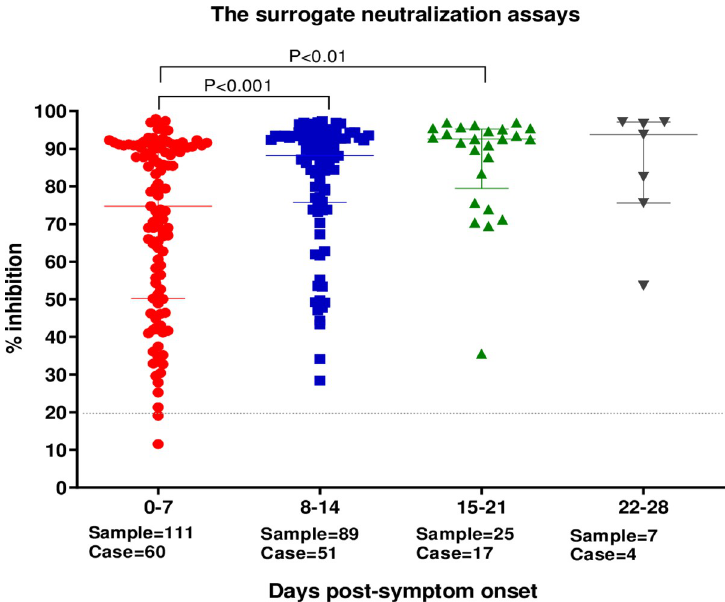
Fig 2. Comparison of sVNT results (%inhibition) between COVID-19 patients on different days after symptom onset. The serology test results of 0–7, 8–14, 15–21, 22–28 days after symptom onset were compared (lateral axis), respectively. Each dot represents one tested specimen and the vertical axis represents the %inhibition of SARS-CoV-2 NAbs tested by sVNT. The dash line represents the cutoff at 20% inhibition. The horizontal lines indicates the median interquartile range (IQR). The p values were calculated from two-tailed